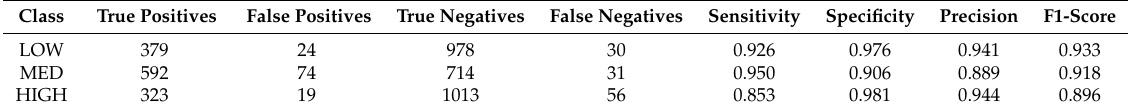
Table 11. Additional metrics obtained for Arousal (Test) classification with the GSR + ECG system. Class